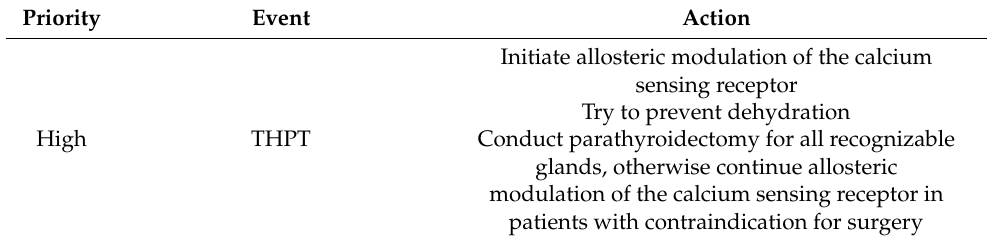
Table 3. Cont. Priority Event Action High THPT